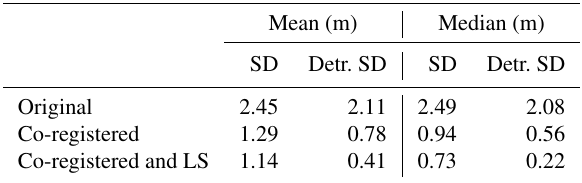
Table 4. Results of least-squares DEM correction. Statistics com- puted for 2010–2015 WorldView/GeoEye DEMs and ATM/LVIS altimetry data over dynamic control surfaces ( n = 4–44 at each pixel, sample of ∼ 6 . 1 × 10 5 pixels, covering ∼ 4 × 10 4 km 2 ). All metrics show decreased spread after correction, with median values less prone to